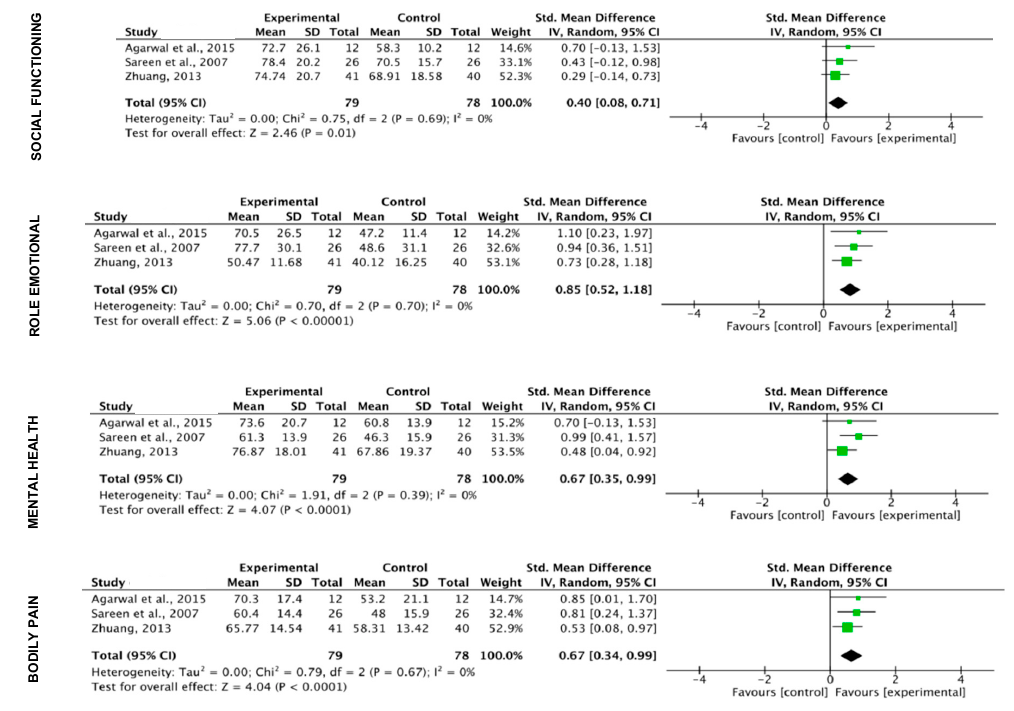
ff ect of programs based on oriental practices on quality of life. Figure 7. Effect of programs based on oriental practices on quality of life. Figure 7. E